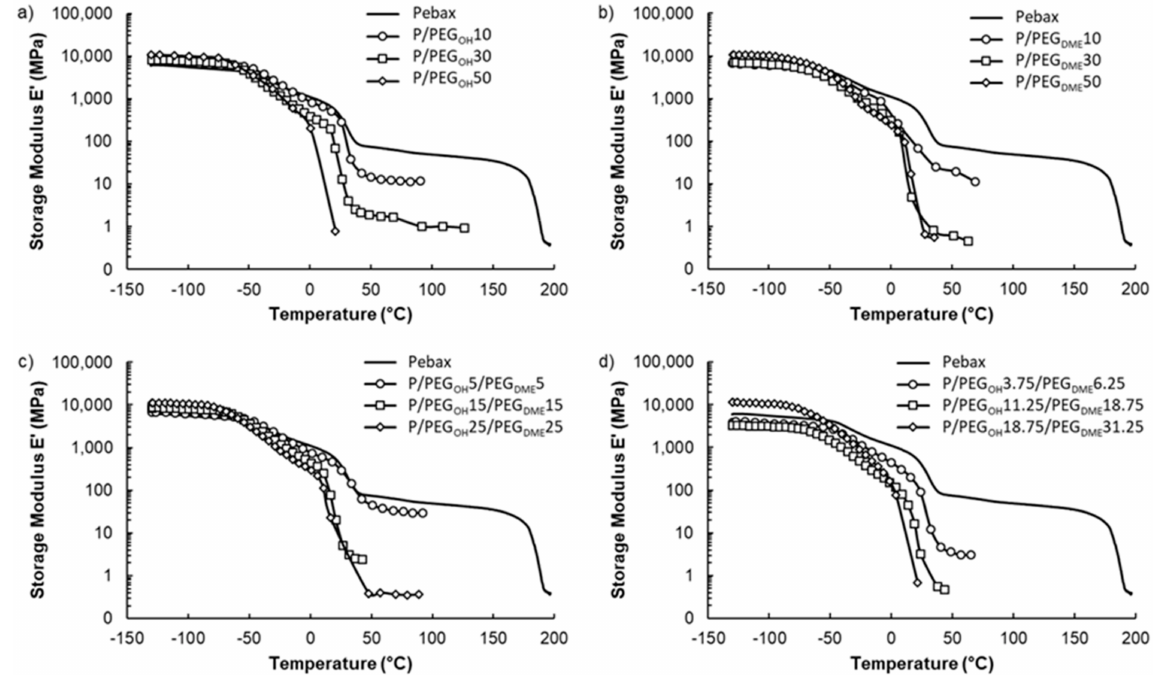
Figure 8. DMA curves showing the thermo-mechanical properties of the pristine Pebax ® film, the Pebax ® /PEG OH films ( a ), the Pebax ® /PEG DME films ( b ), the Pebax ® /PEG OH /PEG DME films with a 50/50 wt.% PEG OH /PEG DME ratio ( c ), and the Pebax ® /PEG OH /PEG DME films with a 37.5/62.5 wt.% PEG OH /PEG DME ratio ( d